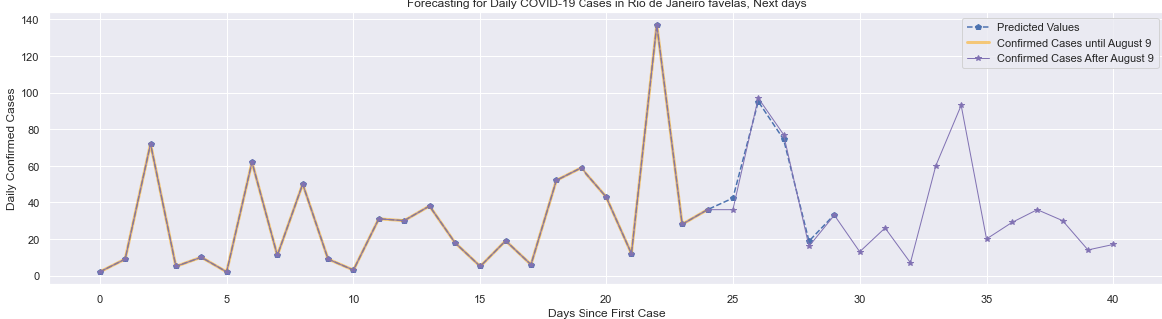
Figure 20. Forecasting Results for Daily COVID-19 cases in Rio favelas.